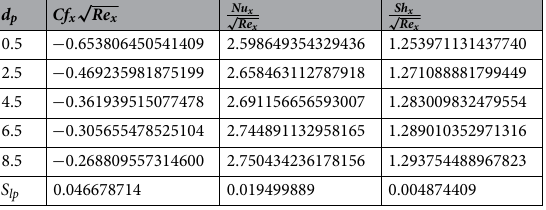
0.1 , and D 100 , S r = ∞ =